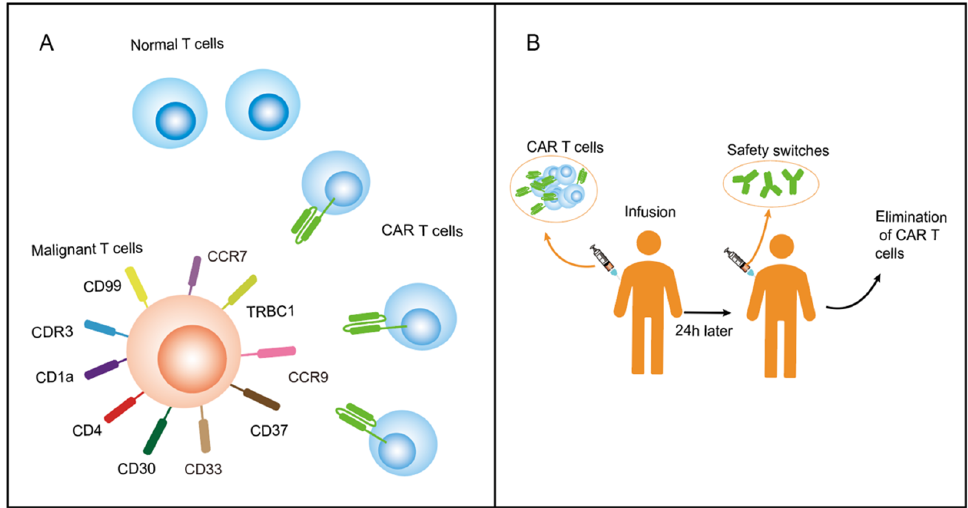
Figure 4. Proposed solutions of T-cell aplasia. ( A ). Select a specific antigen of malignant T cells, which has no expression or limited expression on normal T cells. ( B ). Incorporate switches into the CAR constructs to kill the CAR T cells after they perform the antitumor function.